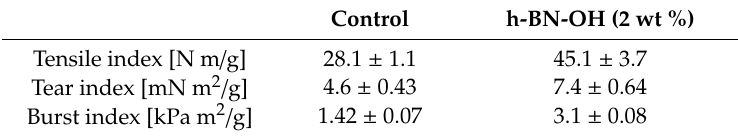
Table 1. The e ff ect of the nanofiller on the mechanical properties of